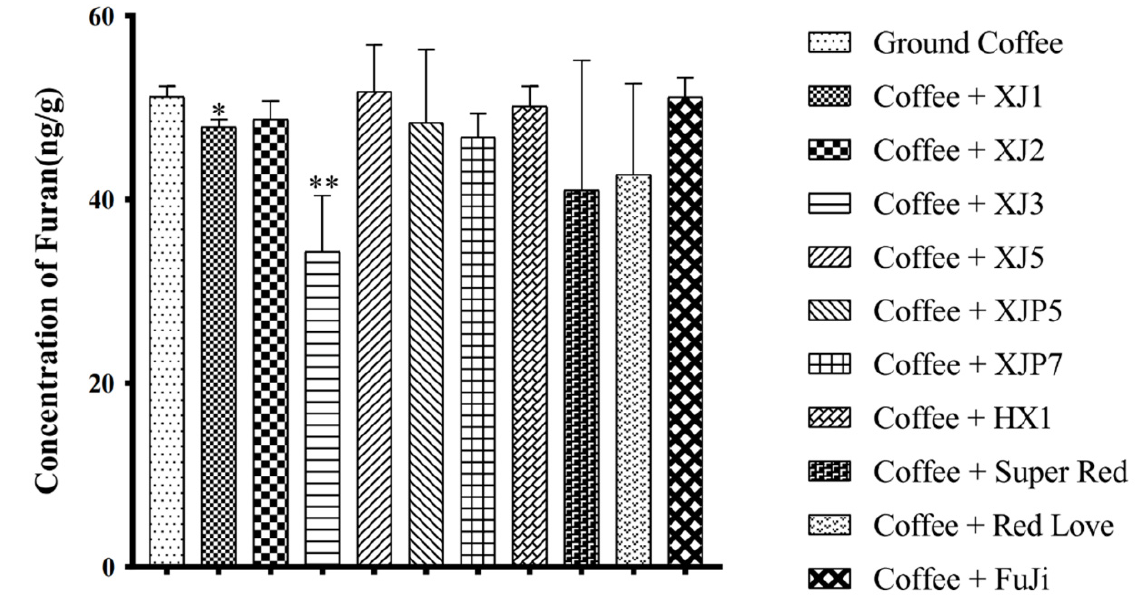
Figure 3. The reduction effect of different varieties of RAAE on furan content in ground coffee. * means p < 0.05, and ** means p < 0.01.